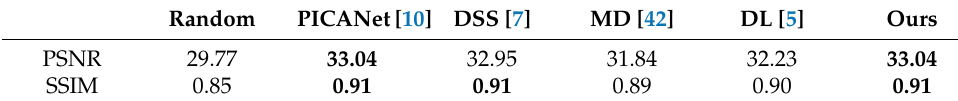
Table 8. Ablation study on the impact of different components.